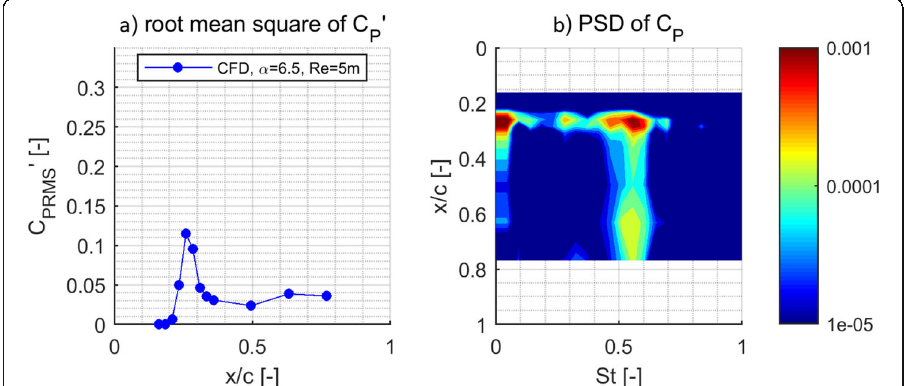
Fig. 9 Computed C PRMS ’ ( a ) and PSD ( b ) at η = 0.6 for α =